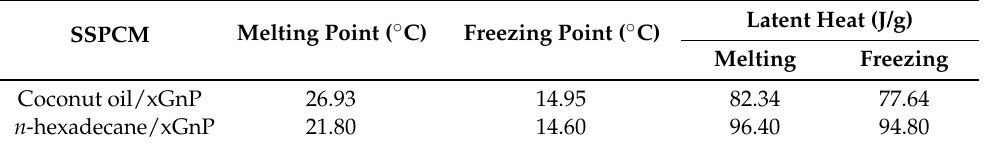
Table 5. DSC analysis of coconut oil/xGnP and n ‐ hexadecane/xGnP SSPCMs [24,28].